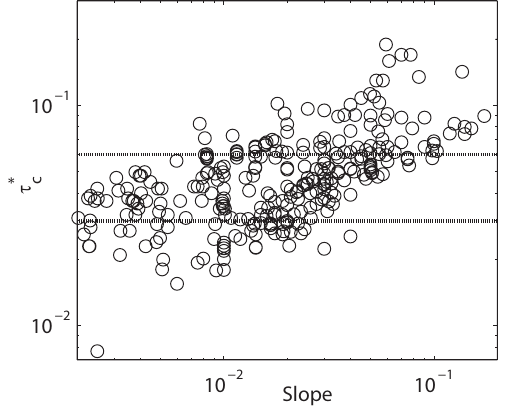
Figure 1. Threshold of motion data from both field and experi- mental studies. A power law regression to these data gives R 2 = 0 . 34, indicating that a majority of the variability is not explained by slope alone. Dotted lines indicate common range of τ ∗ c = 0 . 03 to 0.06 often assumed for modeling transport, although measured data fall well out of this range. Data have been additionally fil- tered to only include D 50 > 2mm (i.e., gravel) and slopes between 0.002 and 0.2. Data were compiled and provided by Prancevic and Lamb (2015), based in part on Buffington and Montgomery (1997), with additional data from Olinde (2015) and Lenzi et al.